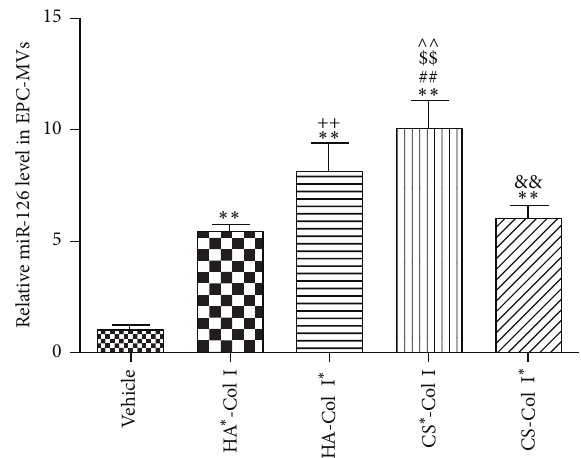
Figure 6: Effects of multilayer composite biomaterial membranes on the level of miR-126 in EPCs-MVs. miR-126 level in EPC-MVs from CS ∗ -Col I group was the highest. The miR-126 level in EPCs- MVs from HA-Col I ∗ group was higher than that from HA ∗ -Col I group, and miR-126 in EPCs-MVs from CS-Col I ∗ group was lower thanthatfromCS ∗ -ColIgroup. ∗∗ 𝑝 < 0.01 versusvehicle, ## , $$ ,∧∧ 𝑝 < 0.01 versus HA ∗ -Col I, HA-Col I ∗ , or CS-Col I ∗ , ++ 𝑝 < 0.05 versus HA ∗ -Col I, and && 𝑝 < 0.05 versus CS ∗ -Col I, 𝑛 = 3 /group.